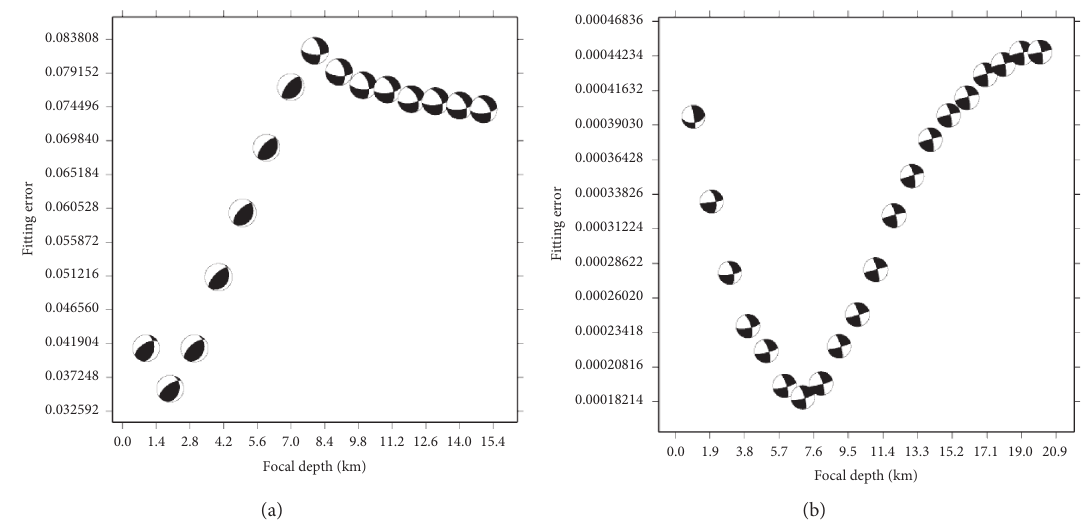
Figure 9: Change of focal mechanism with depth for two earthquakes: (a) Yongshan M5.3 earthquake, April 5, 2014; (b) Yongshan M5.0 earthquake, August 7, 2014.